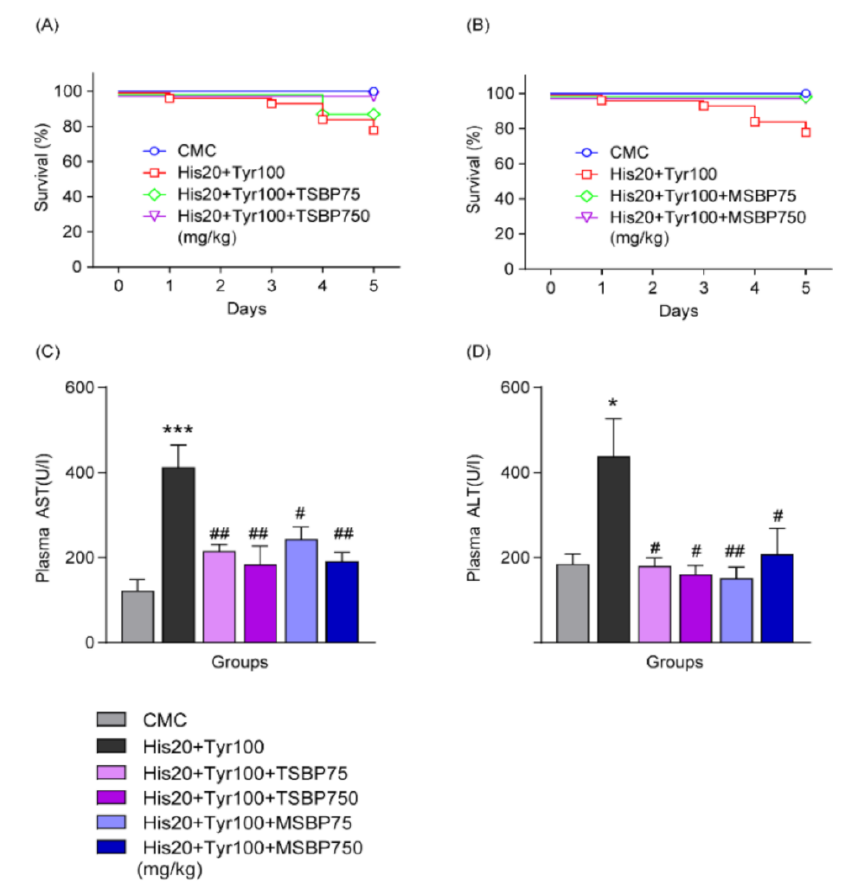
Figure 5. Reduction in biogenic amine-induced toxic effects by fermented soybean paste in obesity. ( A ) Effect of TSBP on survival rate changes caused by biogenic amine administrations and HFD-induced obesity. ( B ) Effect of MSBP on survival rate changes caused by biogenic amine administrations and HFD-induced obesity. ( C ) Changes in blood AST and ( D ) ALT levels caused by biogenic amines and fermented soybean paste in HFD-induced obesity. * p < 0.05, *** p < 0.001 vs. HFD + CMC; # p < 0.05, ## p < 0.01 vs. HFD + histamine 20 mg/kg + tyramine 100 mg/kg. Data are shown as mean ±